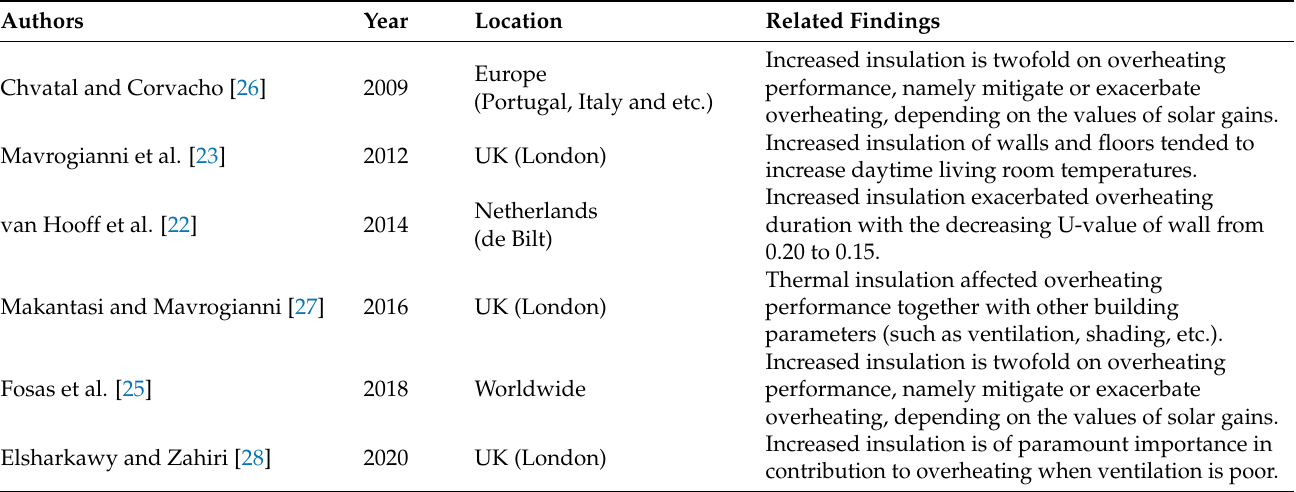
Table 1. Findings of selected studies on relationship between increased insulation and overheating